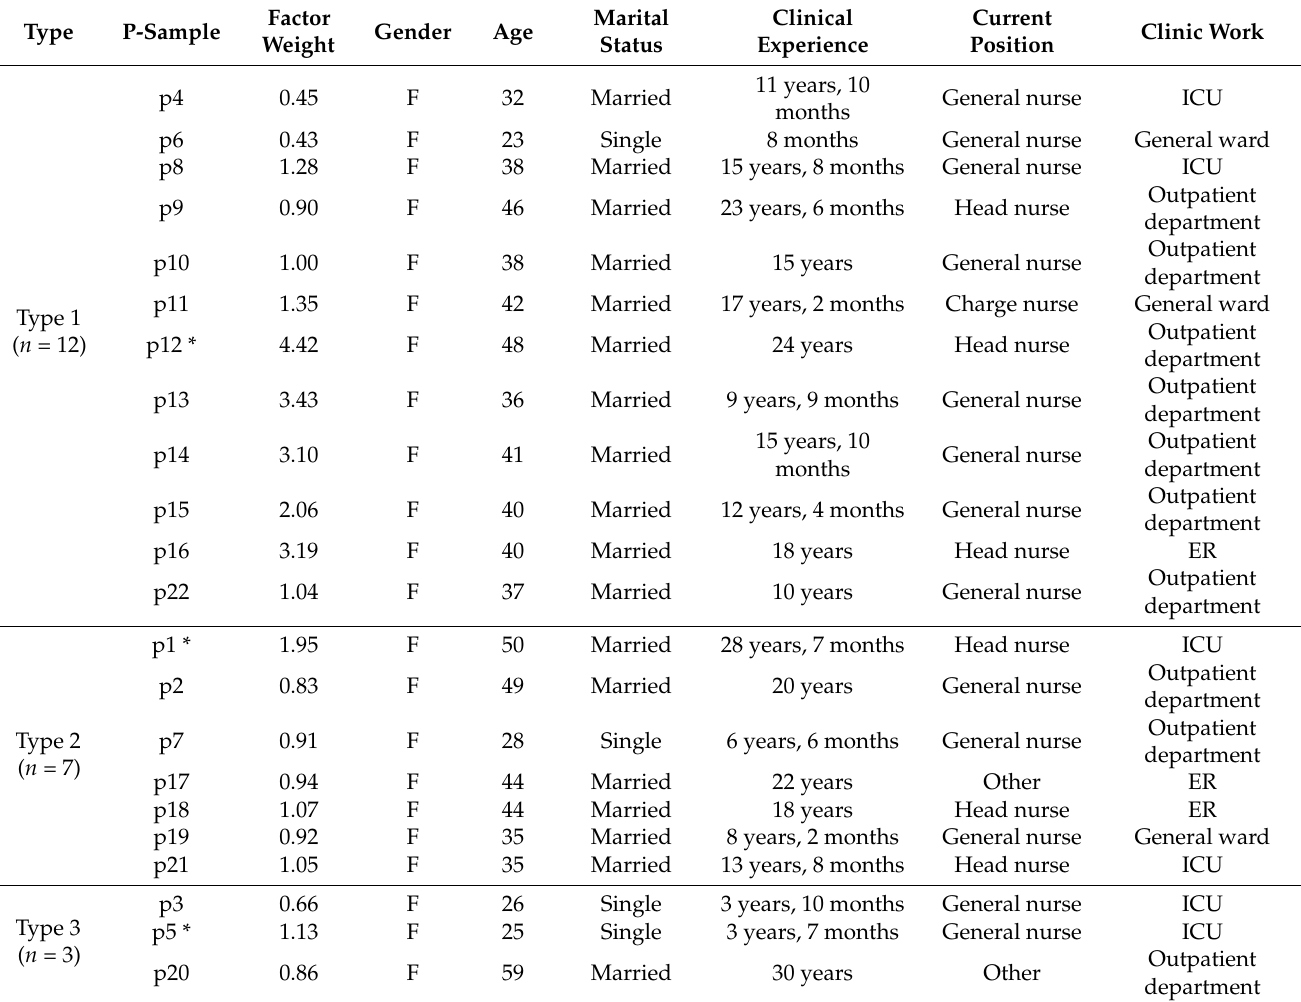
Table 1. General characteristics and factor weights of the P-sample for each type ( n =